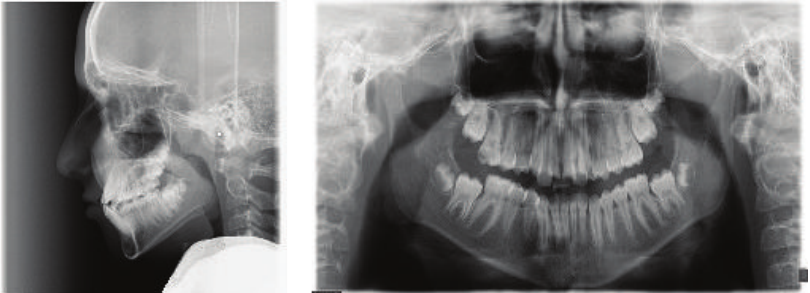
Figure 2: Pretreatment lateral cephalometry and panoramic